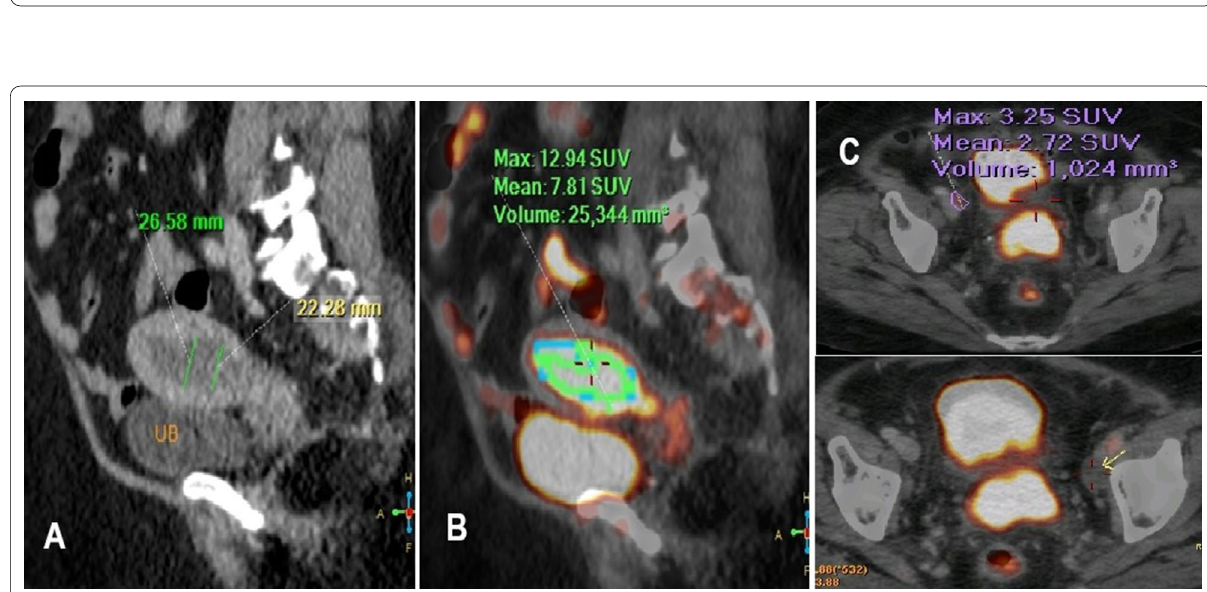
Fig. 2 The uterus is mildly enlarged in size, showing irregular hypermetabolic hypodense remarkable endometrial soft tissue thickening reaching up to 26.5 mm in maximal thickness with zones of active myometrial invasion at the fundus and posterior wall [image A ], achieving up to 12.9 SUV max , 7.81 SUV mean and MTV 1024 mm 3 on corresponding PET images [image B ]. A small right external iliac LN is noted [image C superior = image], measuring about 10 mm achieving 3.25 SUV max, 2.7 SUVmean and Volume 1024 mm3. Another nonavid larger LN seen in the opposite = left external iliac group [image C , inferior image] measuring about 22 17 mm devoid of any appreciable metabolic activity with loss of its fatty ×